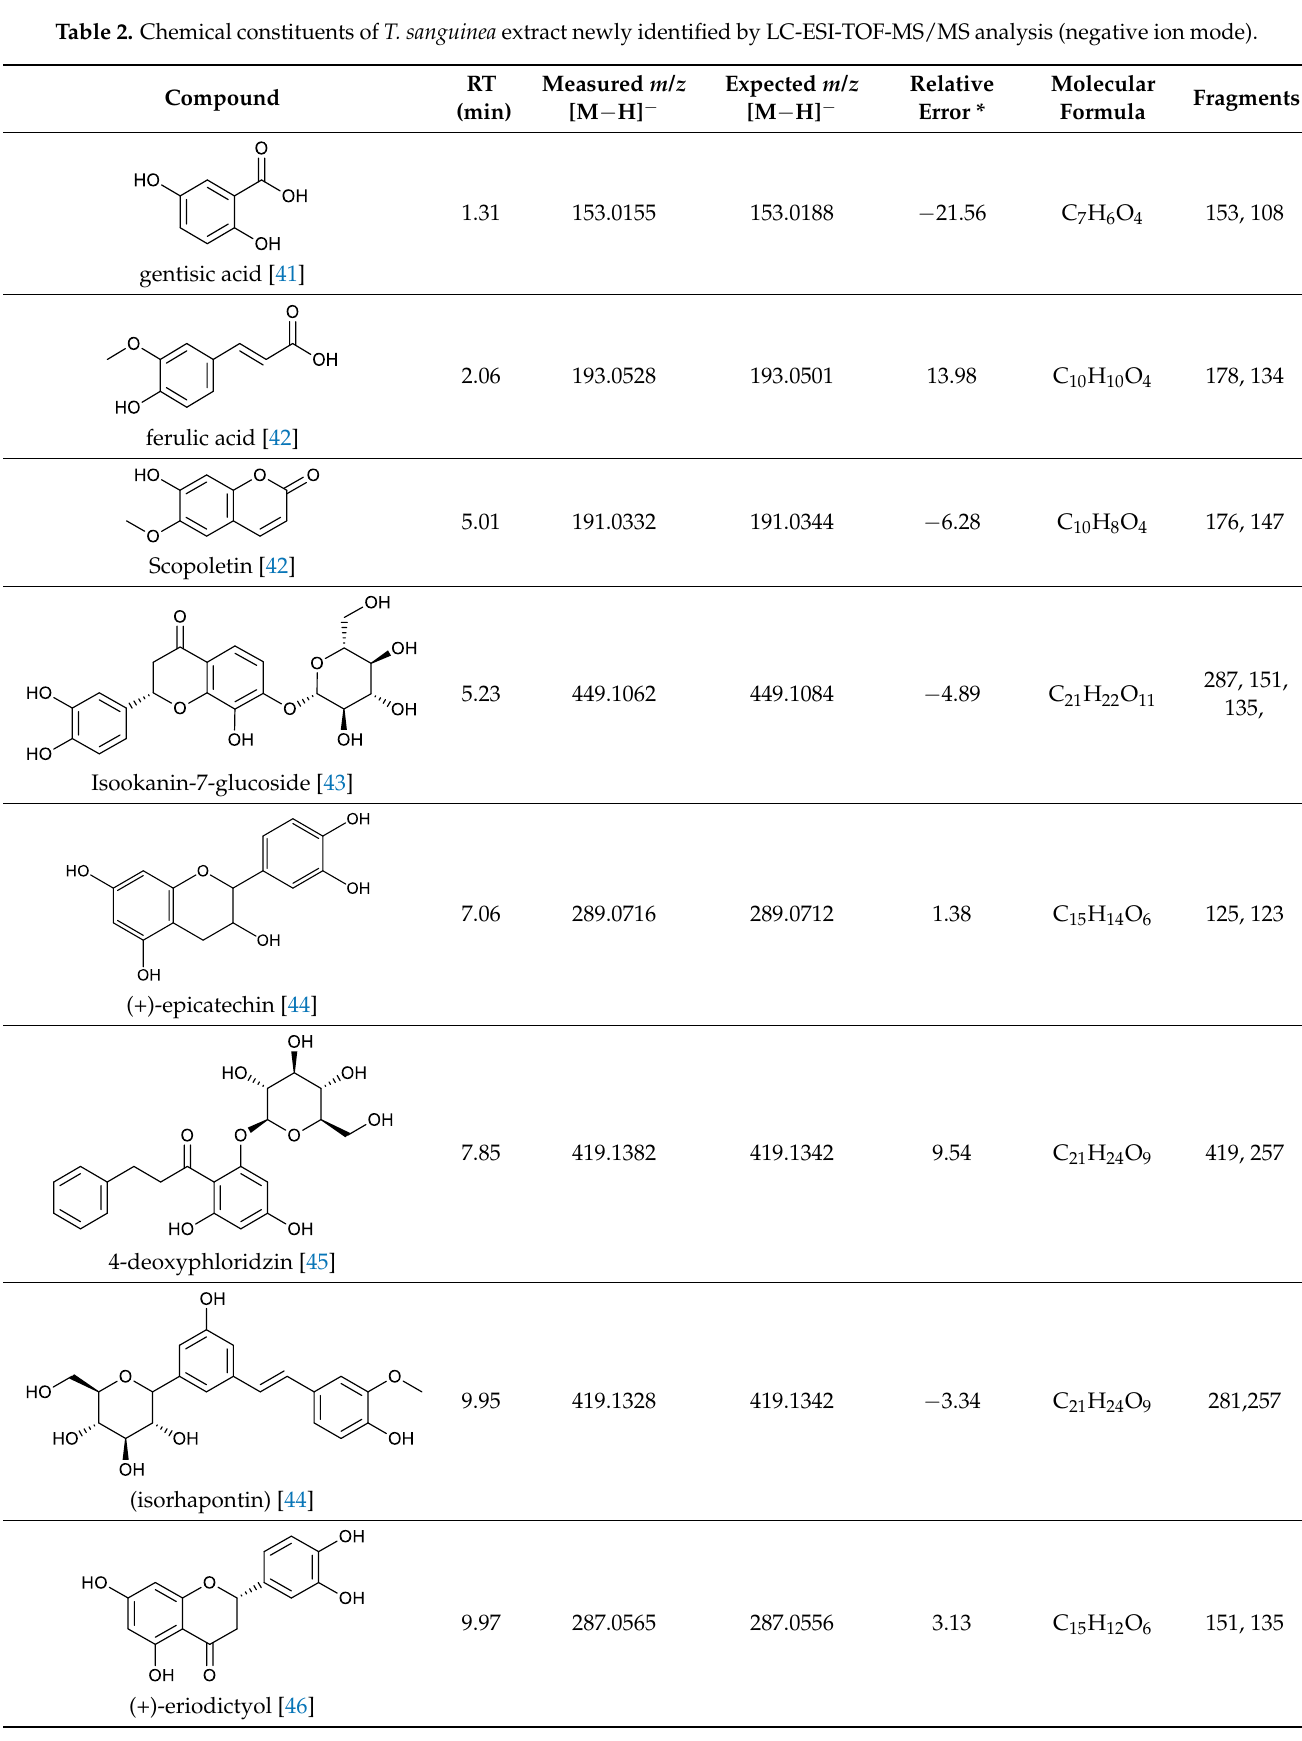
Figure 6. Chromatogram of methanolic extract of T. sanguinea in negative ion mode ( A ) and positive ion mode ( B ). Table 2. Chemical constituents of T. sanguinea extract newly identified by LC-ESI-TOF-MS/MS analysis (negative ion mode).